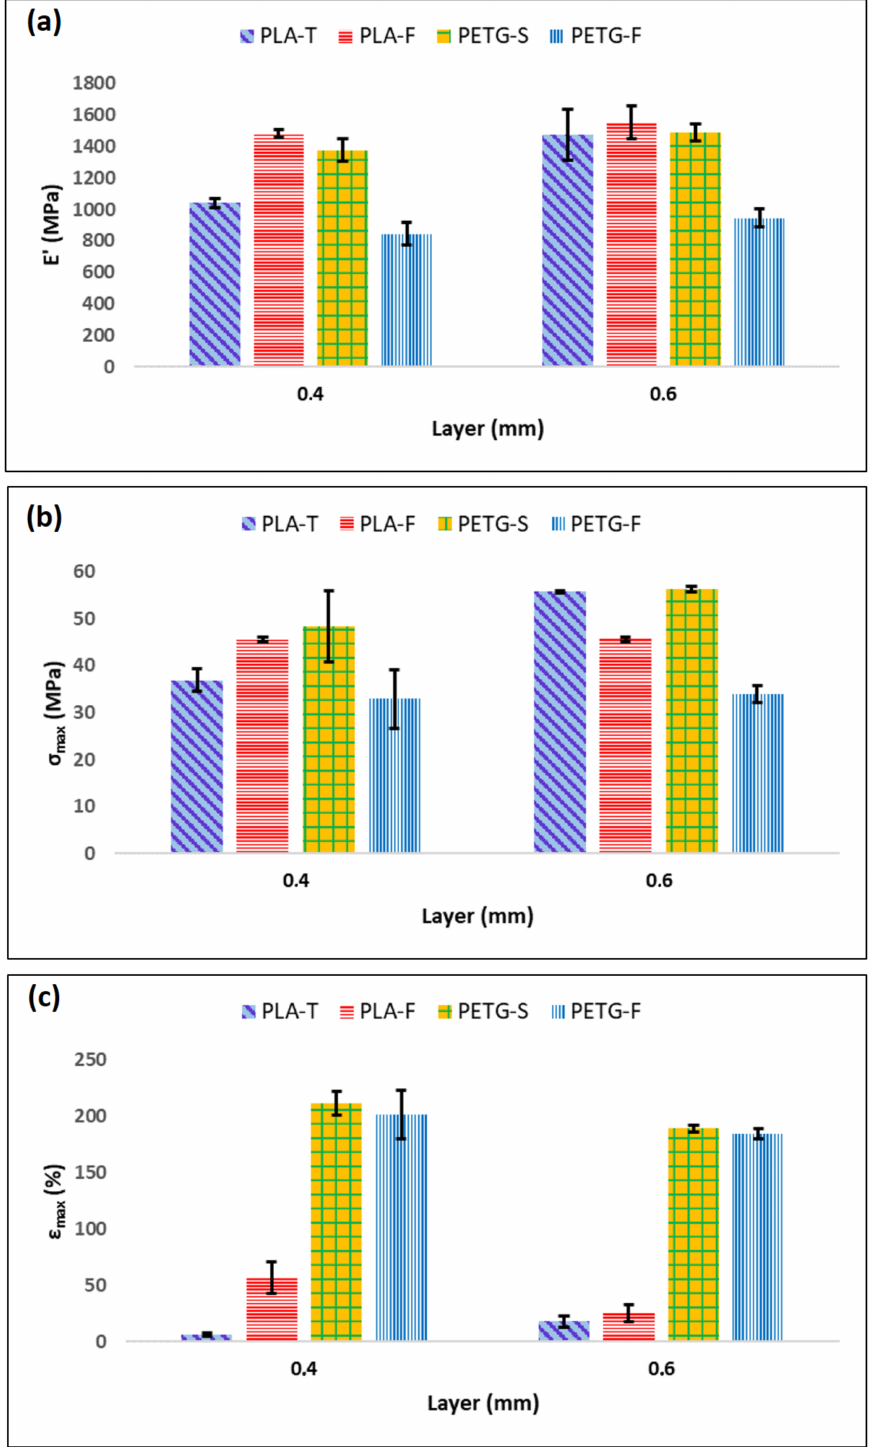
Figure 6. Mechanical properties of PLA and PETG samples in (1,0,0) direction as a function of the layer thickness. ( a ) represents the elastic modulus (E (cid:48) ), ( b ) the yield strength ( σ max ) and ( c ) the elongation at break ( ε max